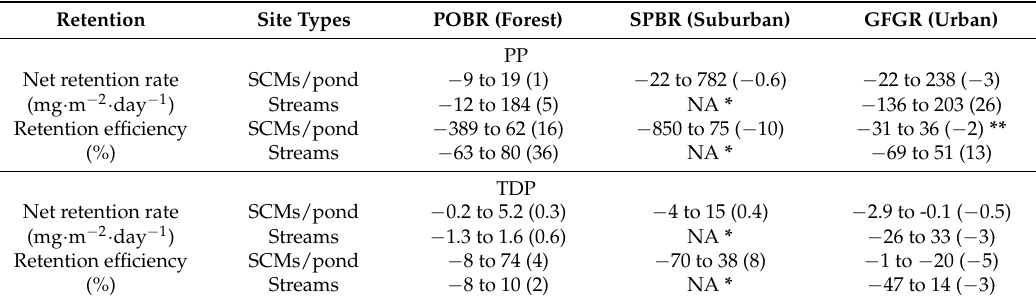
Table 4. Ranges (median) of PP and TDP areal retention rates and retention efficiency ( ∆ PP/total PP inputs × 100%) of the pond/SCMs and free-flowing stream reaches of the three selected watersheds. Positive and negative values refer to retention and release,